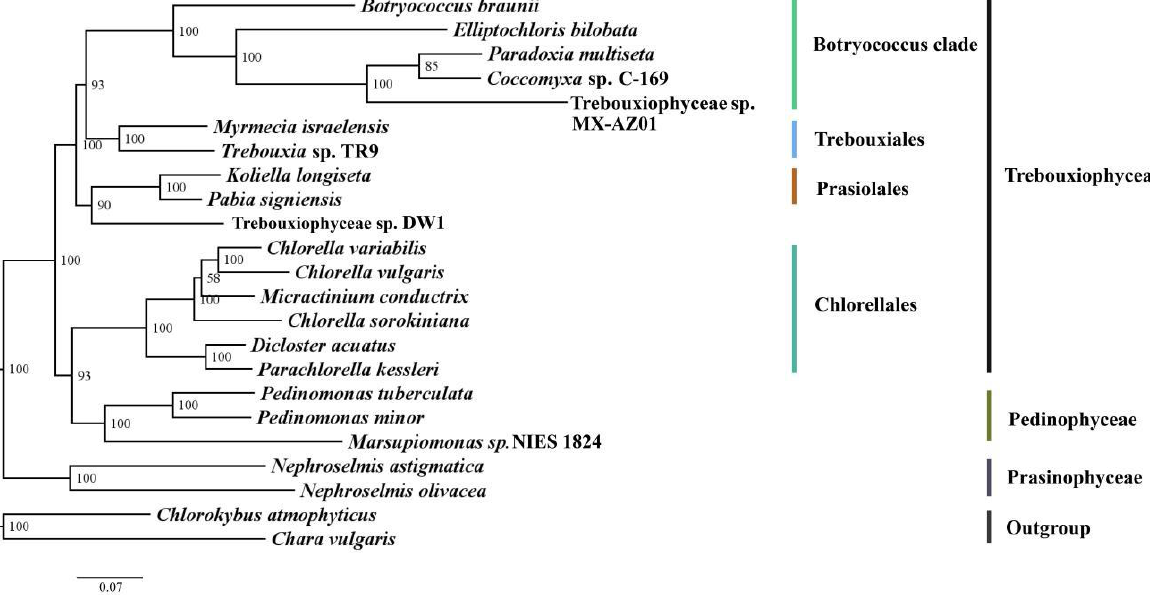
Figure 5. Maximum-likelihood (ML) phylogeny of 21 Trebouxiophyceae and Prasinophyceae species based on an alignment of 23,288 nt of 36 protein-coding genes. Bootstrap values are indicated in the nodes. The scale bar indicates substitutions/site.